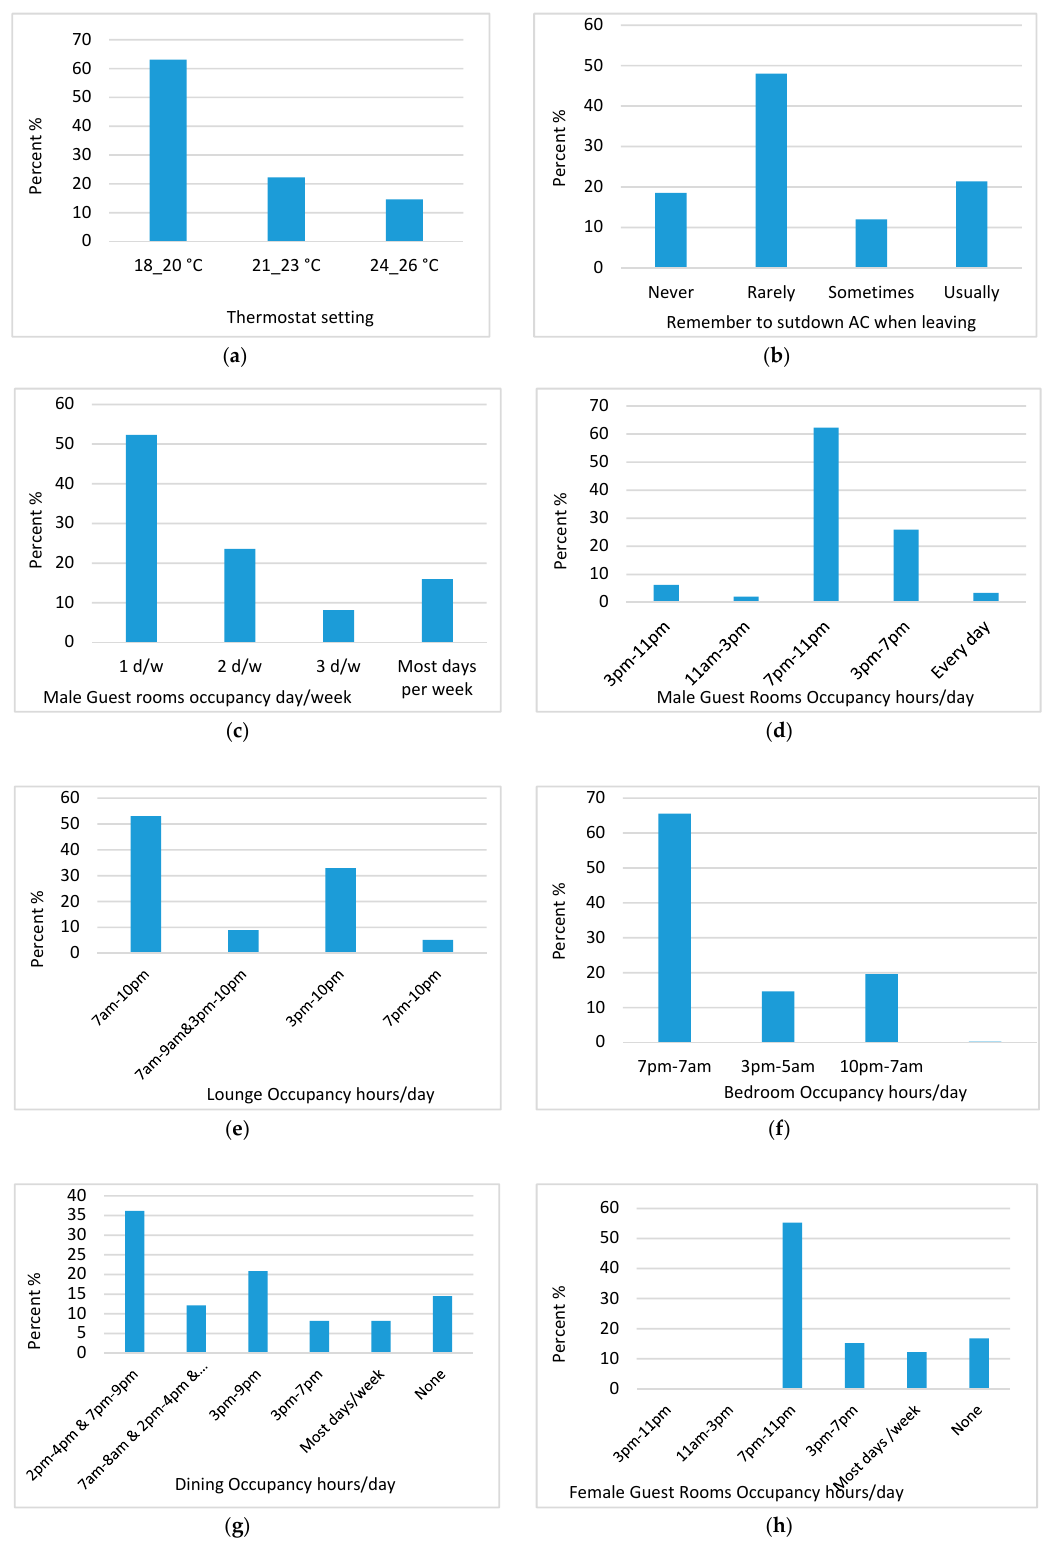
Figure 4. KSA’s household occupancy behavior: ( a ) AC thermostat setting; ( b ) Remember to shutdown AC when leaving; ( c ) Male guest room occupancy day/week; ( d ) Male guest room occupancy hours/day; ( e ) Lounge occupancy hours/day; ( f ) Bedrooms occupancy hours/day; ( g ) Dining room occupancy hours/day; ( h ) Female guest room occupancy hours/day.